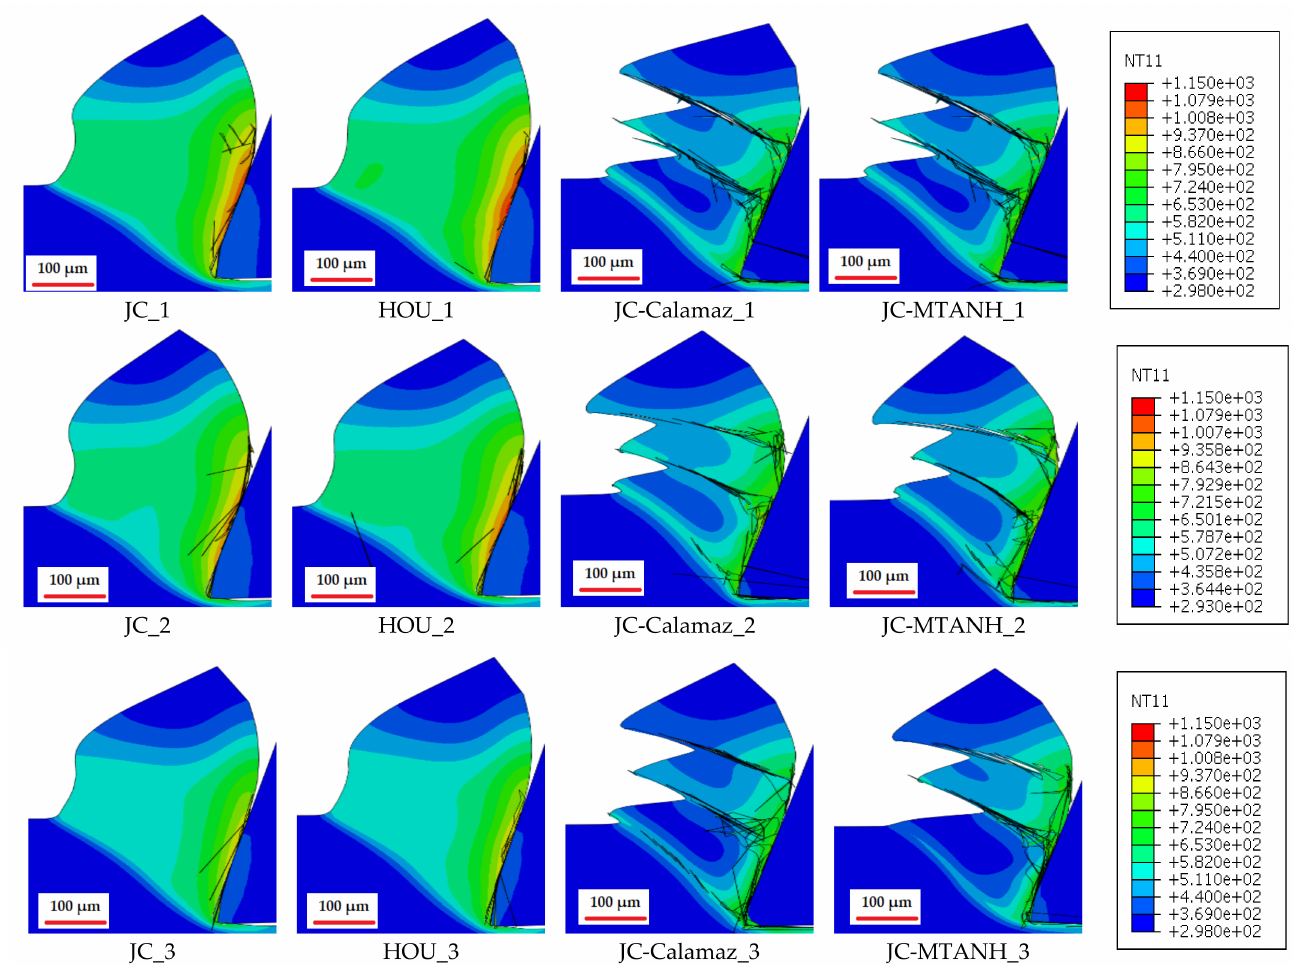
Figure 8. Temperature contour (in K) for uncut chip thickness of 280 µ